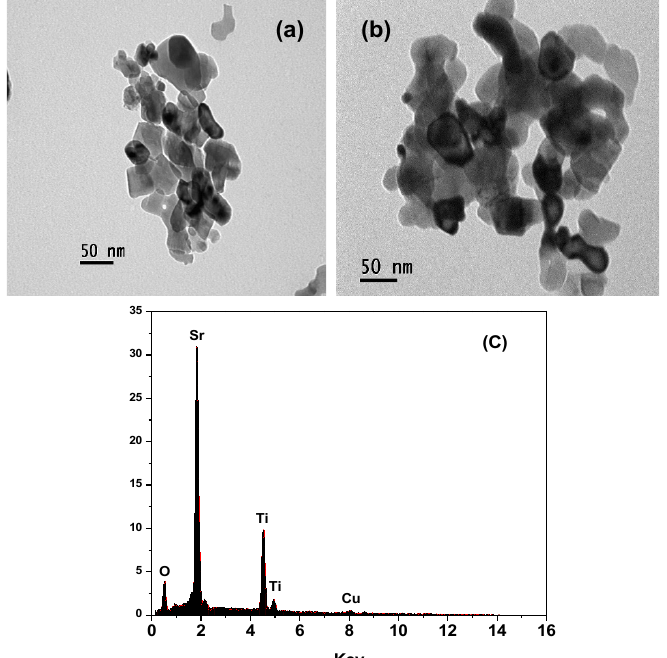
Figure 2. TEM images of SrTiO 3 ( a ), 1.5% CuO ‐ SrTiO 3 ( b ) and EDX spectra of 1.5% CuO ‐ SrTiO 3 ( c ).